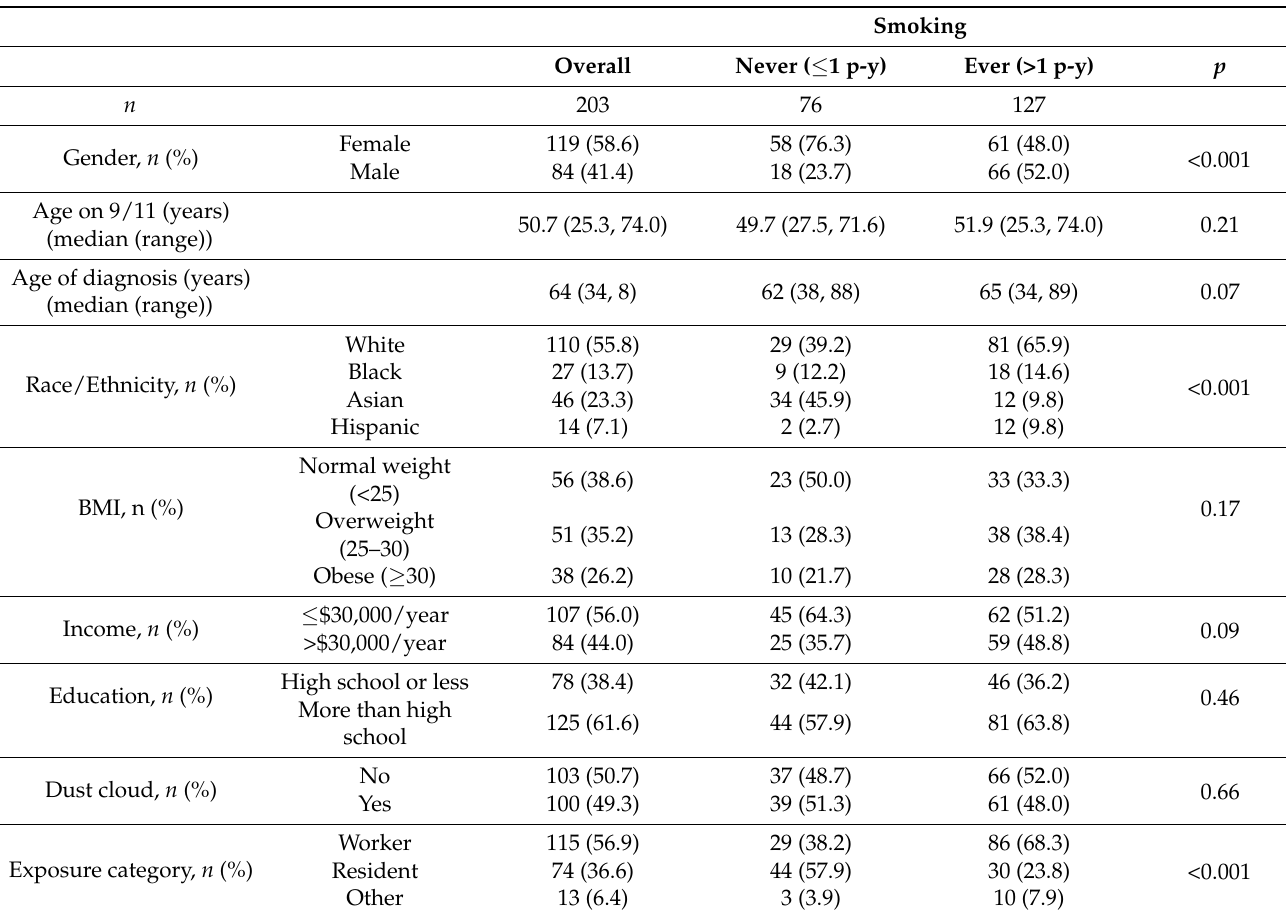
Table 1. Characteristics of lung cancer patients in the World Trade Center Environmental Health Center (WTC EHC) ( n = 203) with smoking history in the WTC